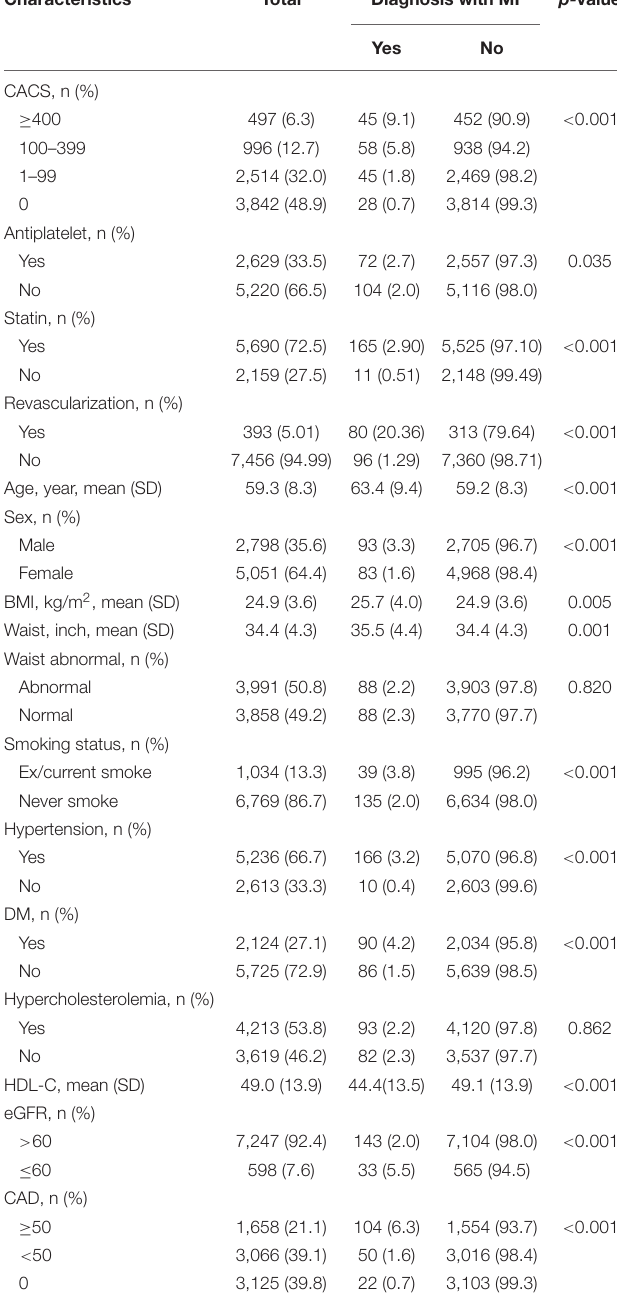
TABLE 1 | Comparison characteristics between patients who diagnosis with MI and without MI.